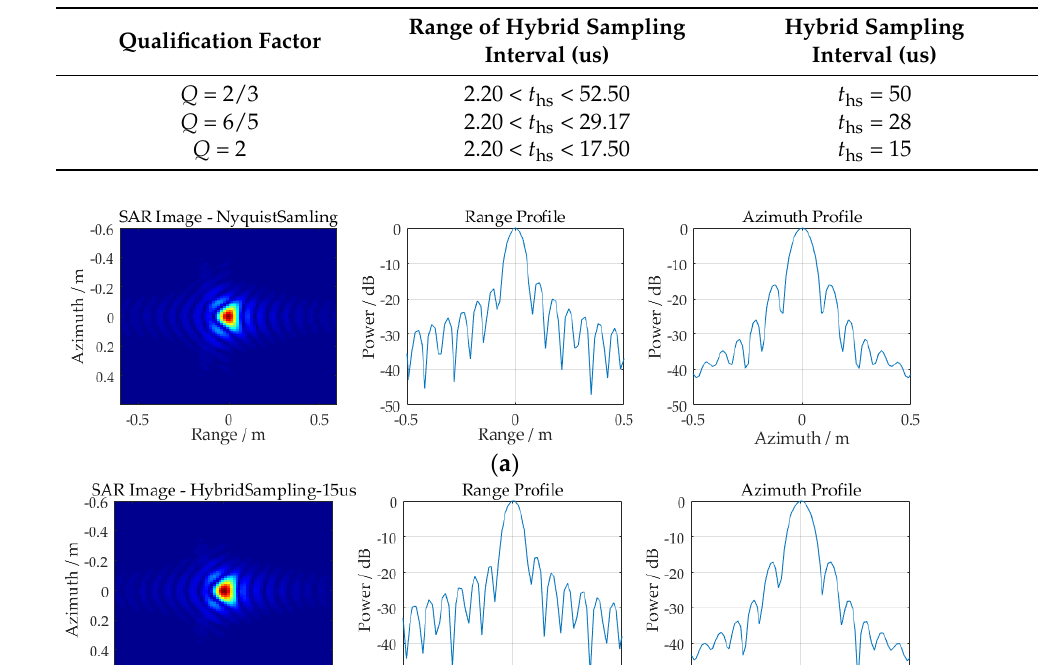
Table 3. The interval between two adjacent hybrid samplings.